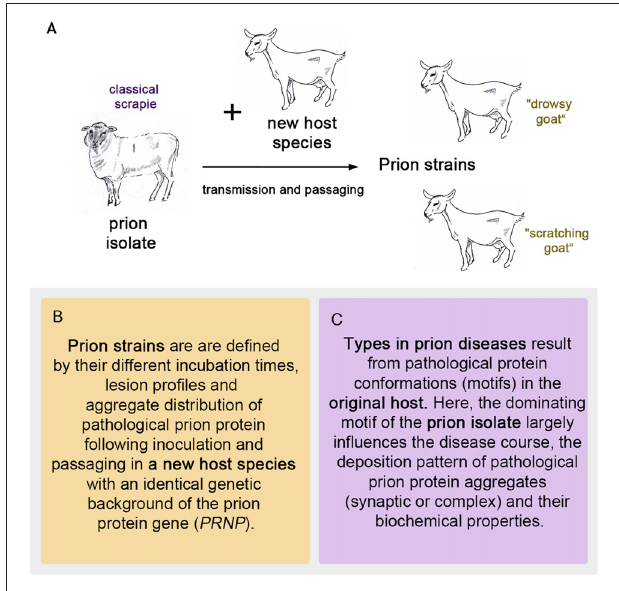
FIGURE 1 | The first prion strains were isolated in goats after passaging sheep scrapie in them, as pictured in (A) . Definition of strains (B) and types (C) in prion